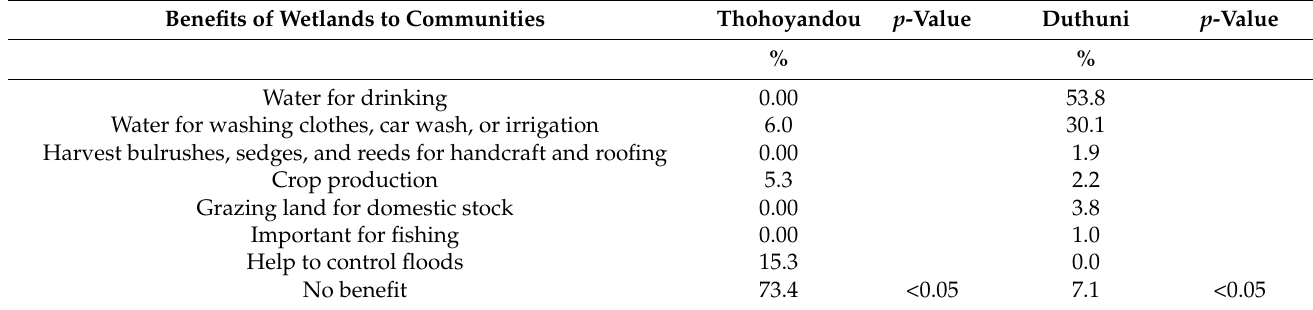
Table 2. Benefits that local people obtain from wetlands in Thohoyandou town ( n = 282) and Duthuni village ( n = 312) falling under the Vhembe region in Limpopo Province of South